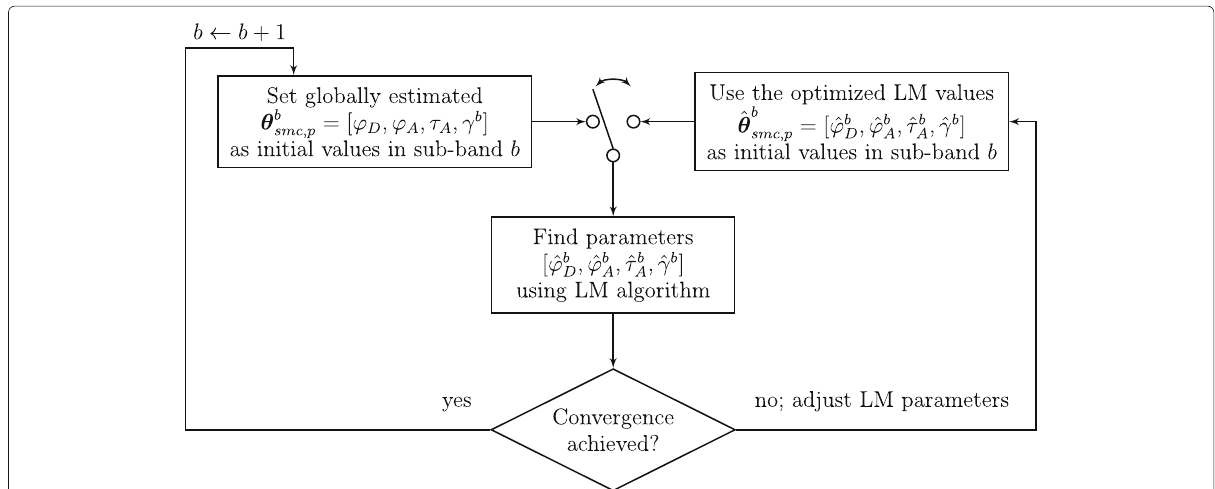
Fig. 2 Flowchart of the estimation and optimization of the SMC. The first iteration of a new sub-band s will use the globally estimated SMC from the initialization procedure as described in Section 4.2.2 as initial values for the search of its optimal values. The switch ensures that subsequent iterations will use the previously optimized (but not converged) values for a better optimization. When convergence is achieved, the next sub-band s + 1 will again use the globally estimated SMC as initial values for the